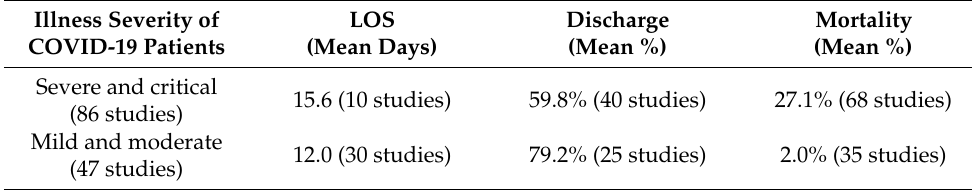
Table 5. Severity categories and health outcomes in COVID-19 patients.